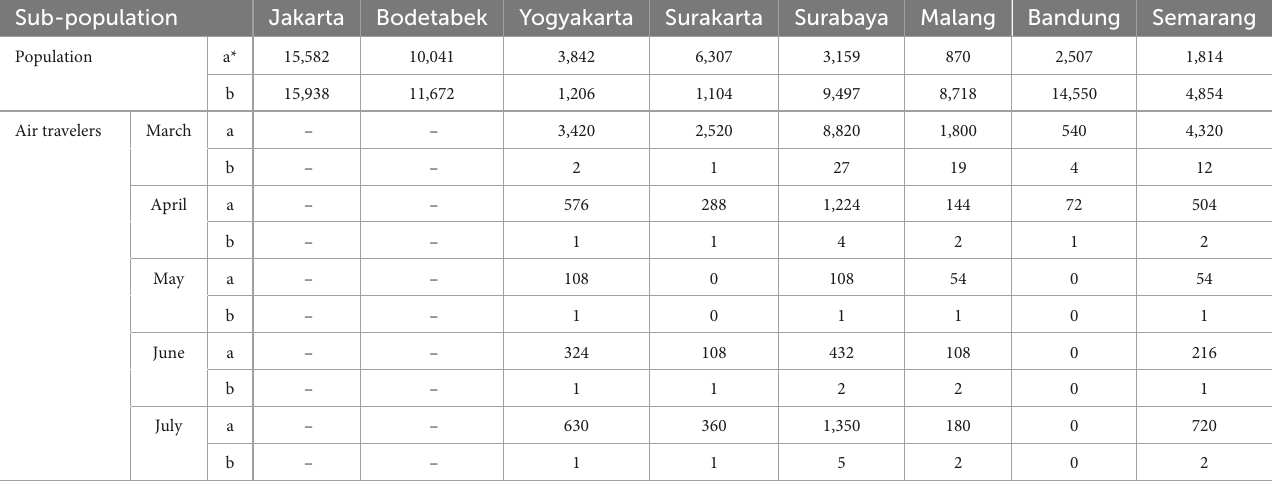
TABLE 3 Actual (a) and model’s (b) population density and their air mobility among sub-populations.